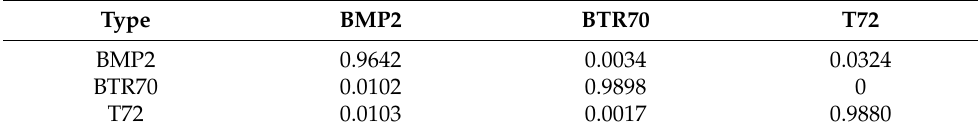
Table 4. Confusion Matrix of the Proposed Method on Three-Target